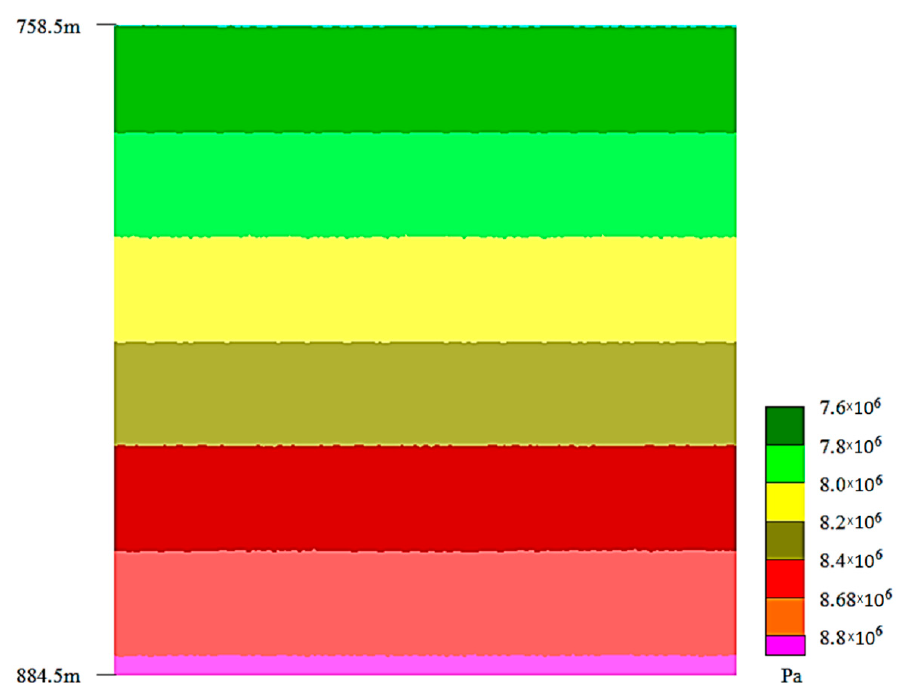
along the canopy and the base are shown in Figure 9. The static analysis presented in Figure 9 is the initial condition for obtaining the numerical model